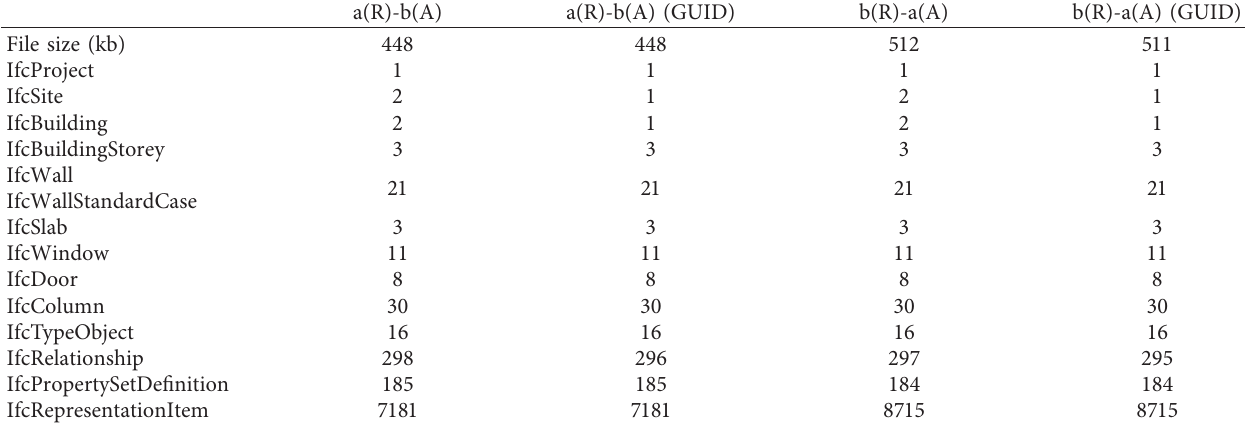
Table 4: Entity statistics for scenarios a and b in different modeling environments.